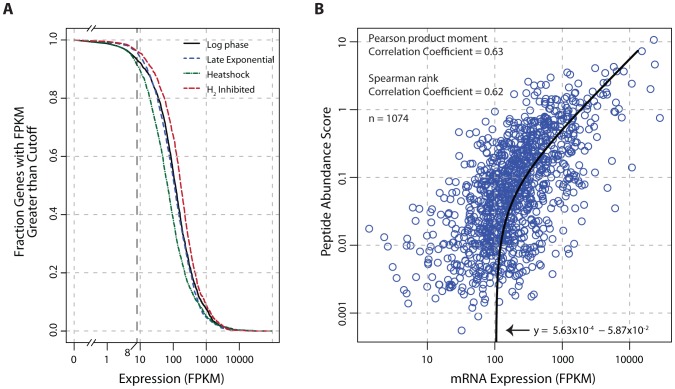
Global analysis of mRNA and protein expression levels.(A) The fraction of transcribed genes as a function of the FPKM threshold. Under growth promoting conditions (log-phase) and early in the transition to stressed conditions (carbon-limited late exponential phase, heat shock, and hydrogen inhibition), 91–96% of the genome is expressed using a conservative FPKM threshold of ≥8. (B) Correlation of mRNA expression and protein abundance. The line of best fit indicates a strong linear relationship (Pearson r = 0.63, p<2.2×10−16 t-test) between transcription and translation. The peptide abundance score for each protein was derived by dividing the total spectral count by the number of possible tryptic peptides (400–2000 m/z up to a charge state (z) of 3, hence a maximum fragment mass of 6000). Abbreviations: FPKM, Fragments Per Kilobase of transcript per Million mapped reads; m/z, mass-to-charge ratio.